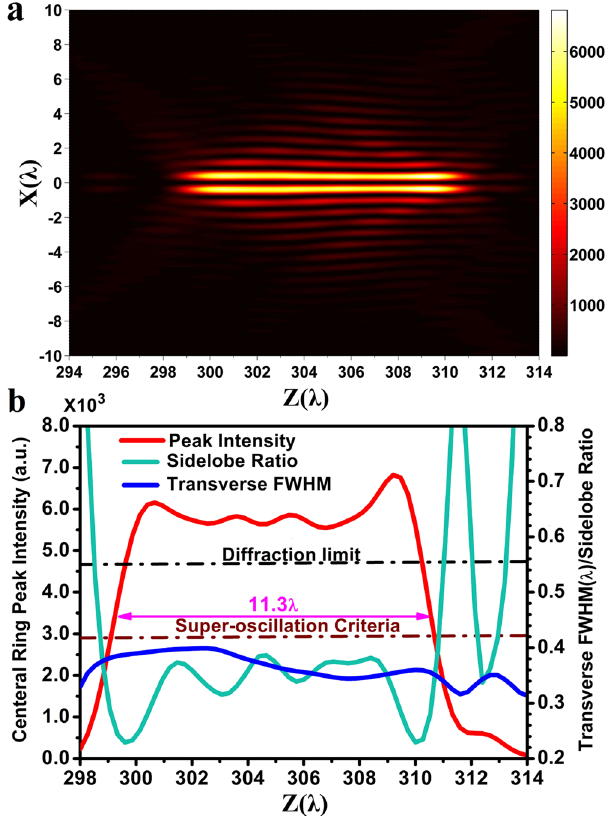
Figure 3. ( a ) The optical intensity distribution in the XZ propagation plane obtained from Eq. (2) using the vectorial angular spectrum method, where the intensity is plotted in arbitrary unit. ( b ) The theoretical central ring peak intensity (red), the transverse FWHM (blue), and sidelobe ratio (green) distributions along the propagation direction, where the black and wine-colored dashed-dotted lines indicate the diffraction limit and super-oscillatory criterion,